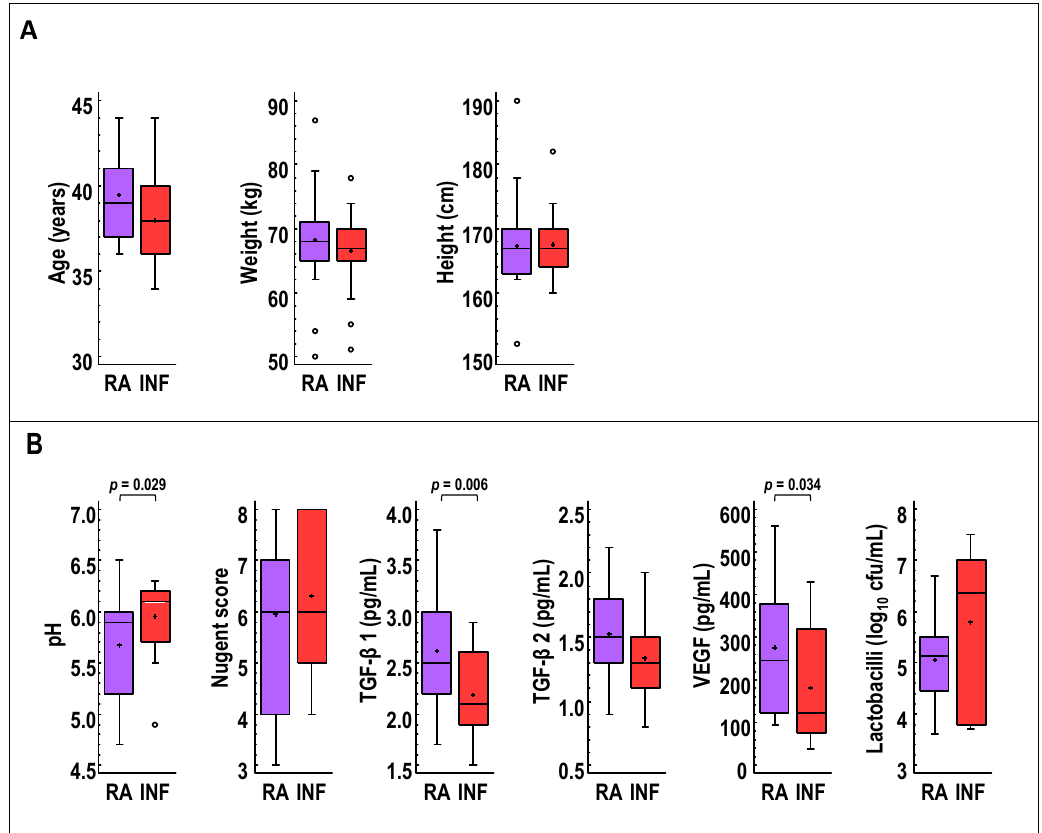
Figure 2. Comparison of selected baseline ( A ) demographic characteristics (age, weight and height) and ( B ) vaginal parameters (pH, Nugent score, TGF- β 1, TGF- β 2, and VEGF concentrations, and viable Lactobacillus counts) in CVL samples of women with repetitive abortion (RA, purple) and women with infertility of unknown origin (INF, red) at recruitment. For each boxplot, the line and the cross within the box represent the median and mean, respectively. The bottom and top boundaries of each box indicate the first and third quartiles (the 25th and 75th percentiles), respectively. The whiskers represent the lowest and highest values within the 1.5 interquartile range (IQR) and the dots outside the rectangles are suspected outliers (>1.5 × IQR). One-way ANOVA tests were used to compare both